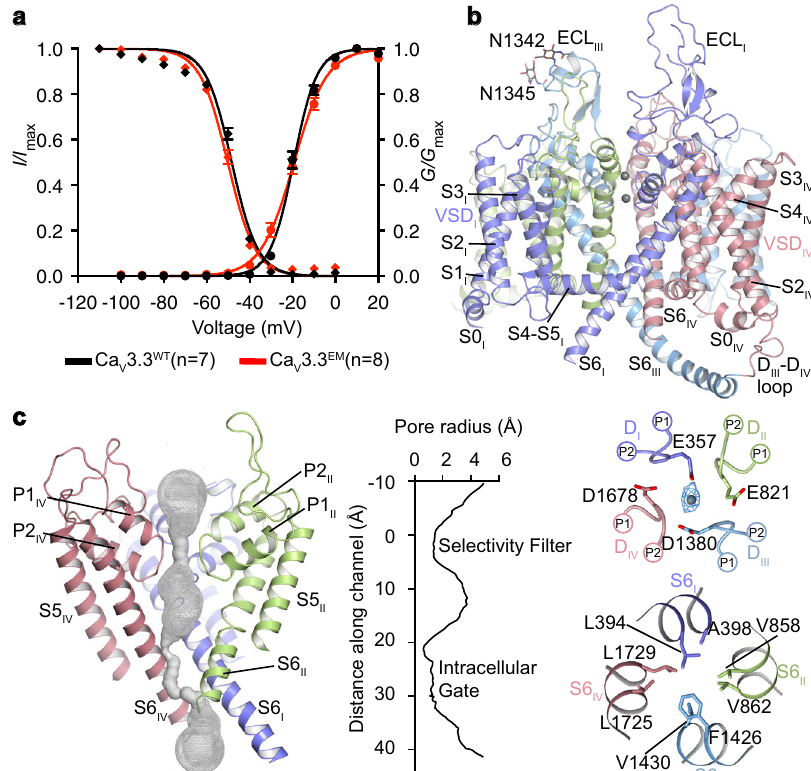
Fig. 1 Architecture of the Ca V 3.3 channel. a The activation (right) and inactivation (left) properties of the truncated Ca V 3.3 EM and full-length wild type (WT) Ca V 3.3 WT . Normalized conductance ( G/G max ) for the activation properties is applied by a held at − 100 mV and then a series of 200 ms voltage steps from − 100 mV to + 20 mV in 10 mV increments. The ion current ( I/I max ) for inactivation (left) properties are assessed with a 3.6 s holding voltages ranging from − 110 mV to 0 mV (10 mV increments) followed by a 150 ms test pulse at − 20 mV. N cells were analyzed (WT, n = 7; EM, n = 8). Data are presented as mean values + / – SEM. Source data are provided as a Source Data fi le. b The overall structure of the Ca V 3.3 apo . The domains of Ca V 3.3 are colored as D I in purple, D II in green, D III in blue, and D IV in salmon. A cation ion in the selectivity fi lter vestibule was presented as a gray sphere. c The ion conducting pathway was calculated by the program HOLE and illustrated by gray dots in the left panel. The selectivity fi lter ring of four negatively charged residues from the four domains is shown in sticks in the upper, and the intracellular gate formed by four S6 helix viewed from extracellular side was shown in the lower of the right panel,